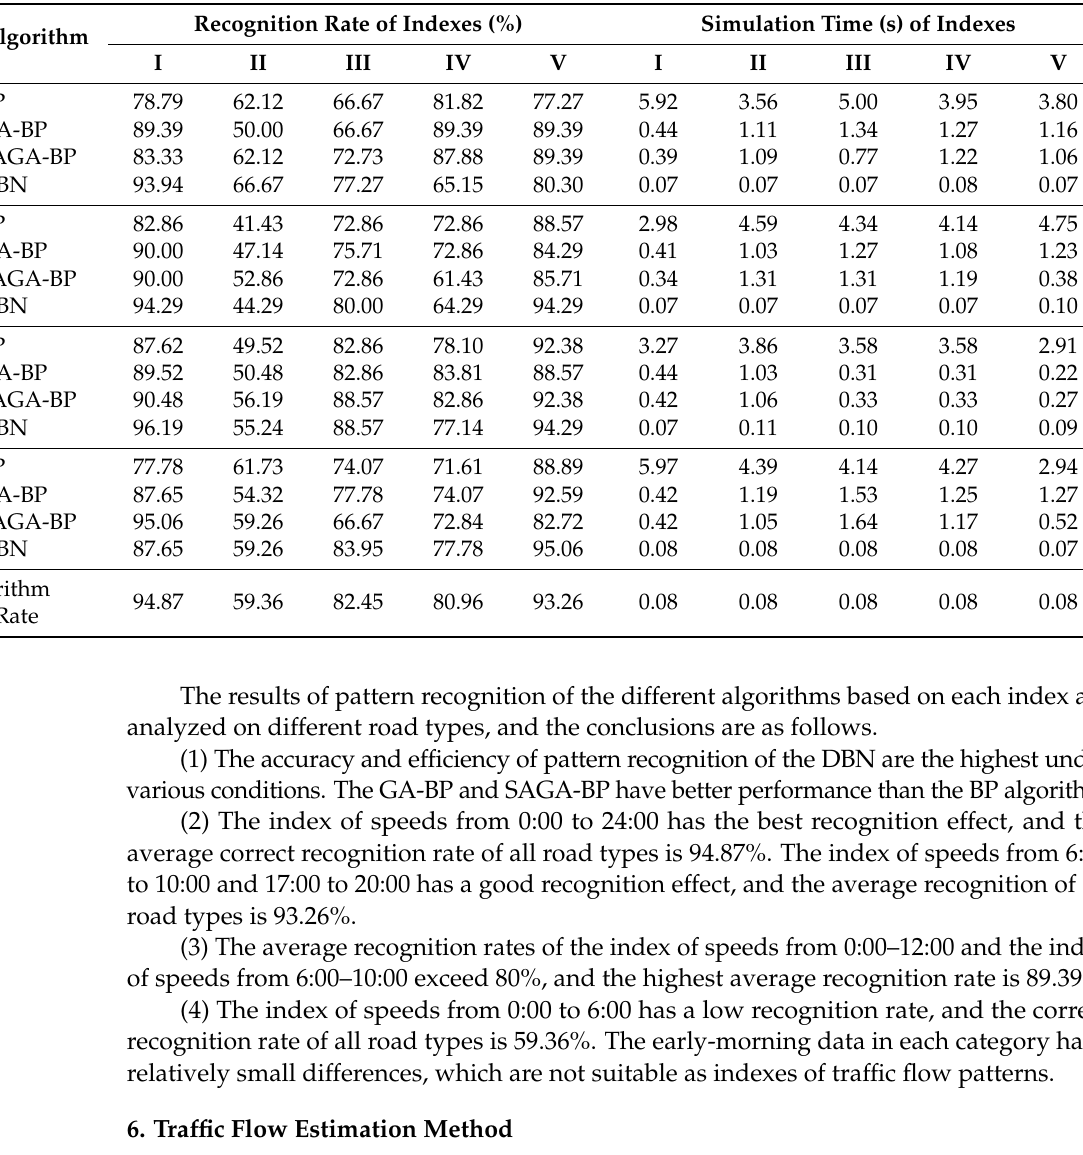
Table 4. Recognition rates and simulation times of different algorithms based on each